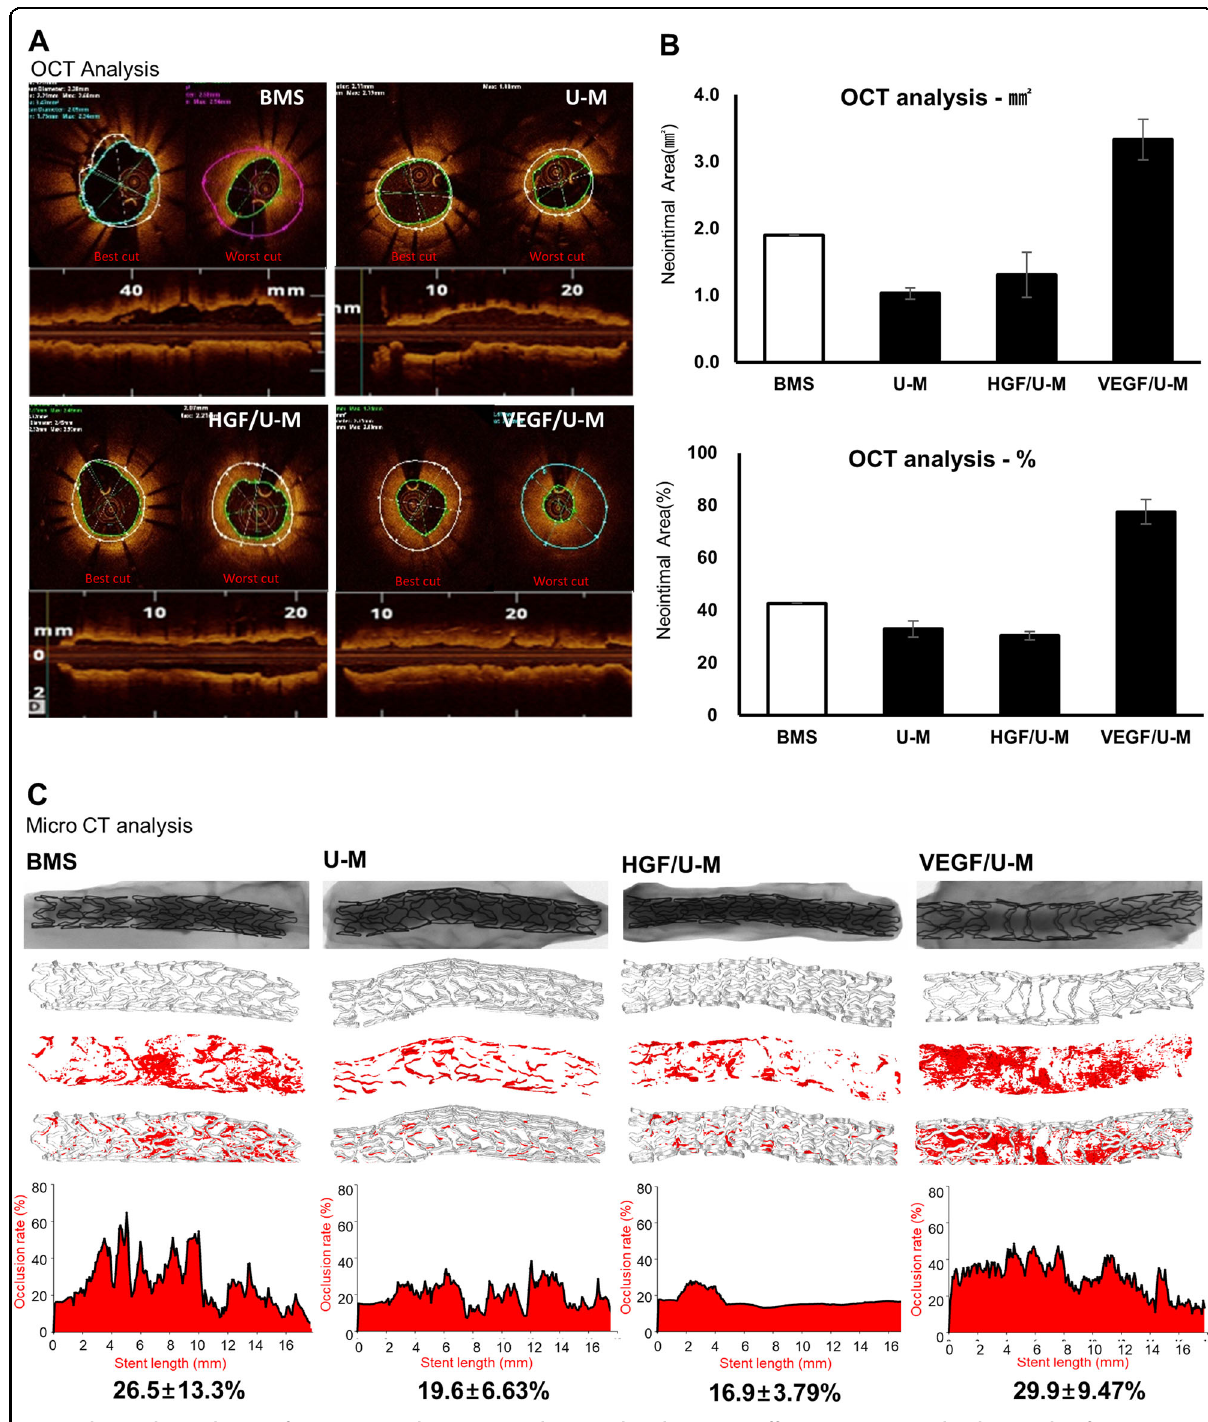
Fig. 3 The single conditions of HGF/U-Ms and VEGF/U-Ms alone produced opposite effects on neointima levels 2 weeks after transplantation. a OCT images showing neointimal degrees 2 weeks after stent transplantation. BMS bare material stent, U-M human U-M-coated stent, HGF/U-M stent coated with HGF/U-Ms, VEGF/U-M stent coated with VEGF/U-Ms. b OCT analysis showing neointimal areas in mm 2 and in % units. c The microCT results were analyzed at a 50 kV/200 μ A spatial resolution with 17- μ m units to show the surface smoothness and neointima areas. N =